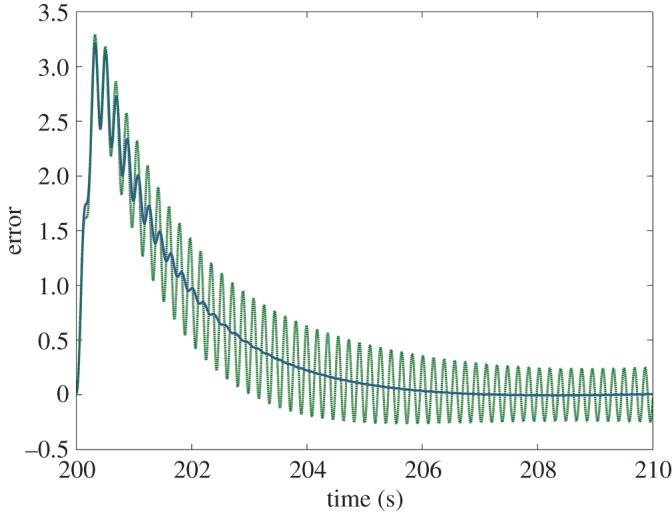
Instantaneous error between the positions of the target and the end-effector (xtarget−xeffector) for the parallel system with K=0.9 (blue line) and the unmodified control loop (green dashed line) along the x-axis in response to a large impulse torque of magnitude 4000 and duration 0.3 s at both arm joints beginning at 200 s. Both systems are subject to the delay terms τ=0s and τf=0.045 s. The parallel system exhibits a significantly reduced response, returning to stability within 5 s.